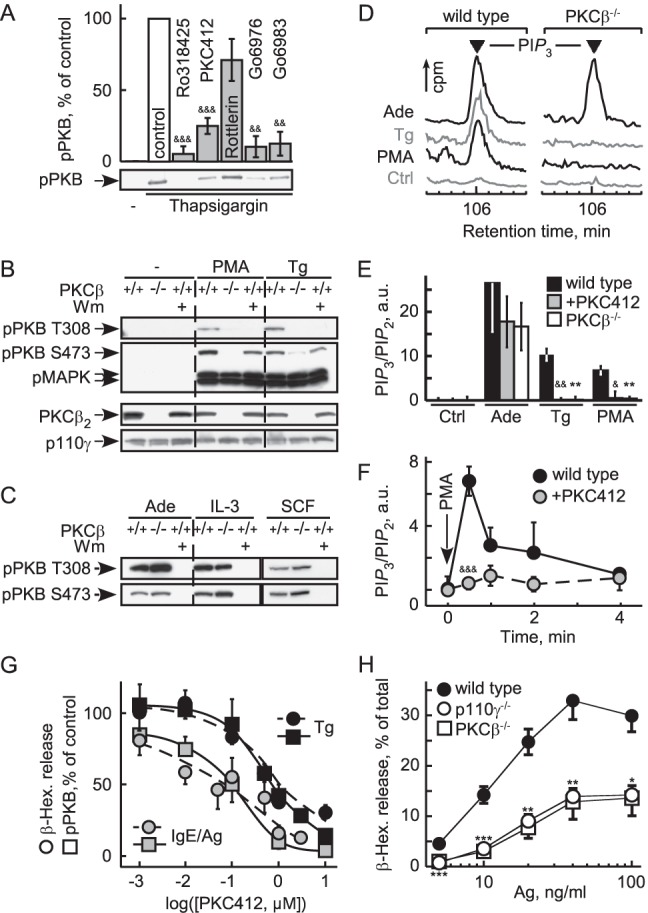
PKCβ relays thapsigargin-induced PI3Kγ activation.(A) Effect of PKC inhibitors on thapsigargin-induced PKB phosphorylation on Ser473 (S473). IL-3 starved BMMCs were preincubated with the indicated compounds for 20 min before stimulation (pan-PKC: Ro318425, Gö6983; classical PKC: PKC412 (CPG41251); classical and atypical PKC: Gö6976; Rotterlin: broad band inhibitor; see Text S1; & refers to comparison with untreated control; p-values see Figure 1). (B) PKB/Akt activation in response to 100 nM PMA or 1 µM thapsigargin was analyzed in wild type and PKCβ−/− BMMCs. Cells were IL-3 deprived as in (A), and were pretreated with wortmannin (Wm, 100 nM) for 15 min before stimulation where indicated. Cells were lysed 2 min after stimulation, and analyzed for phosphorylation of PKB/Akt (T308 and S473) and MAPK (T183/Y185). (C) Wild type and PKCβ−/− BMMCs were stimulated with 1 µM adenosine, 10 ng/ml IL3, or 10 ng/ml SCF, and processed as in (B). (D–F) PtdIns(3,4,5)P
3 (PIP
3) levels were determined in untreated (Ctrl) and classical PKC-inhibitor (PKC412)-treated wild type BMMCs and PKCβ−/− BMMCs after stimulation with 0.5 µM thapsigargin, 200 ng/ml PMA, or 5 µM adenosine (30 s). BMMCs were metabolically labeled with [32P]-orthophosphate, lipids were extracted, deacylated, and applied to high-pressure liquid chromatography (HPLC). (D) shows representative elution peaks of PIP
3 of the HPLC chromatograms. (E) Levels of PIP
3 in relation to PtdIns(4,5)P
2 (PIP
2) were quantified by integration of the peak areas of PIP
3 and PIP
2 and expressed as ratio of PIP
3/PIP
2 (data shown as mean ± standard error of the mean [SEM], n≥4–6). (F) Cellular PIP
3 production was measured over time in wild type BMMCs in response to PMA (200 nM) stimulation in the presence or absence of the classical PKC inhibitor PKC412 (mean ± SEM, n = 3). (G) Granule release and PKB activation (S473) in response to thapsigargin (1 µM) or IgE/antigen (100 ng/ml IgE overnight, 10 ng/ml DNP) was measured in the presence of increasing concentrations of the classical PKC inhibitor PKC412. Cells starved as in (A) were stimulated with IgE/antigen (IgE/Ag) or thapsigargin (Tg), and PKB phosphorylation and β-hexosaminidase release assays were performed in parallel (mean ± SEM, n = 3). (H) β-hexosaminidase release determined in wild type, PKCβ−/−, and p110γ−/− BMMCs incubated with IgE, and stimulated with the indicated antigen (Ag) concentrations (mean ± SEM, n = 5; * refer to comparison with wild type control. Only the higher p-values of the overlapping data points are indicated).